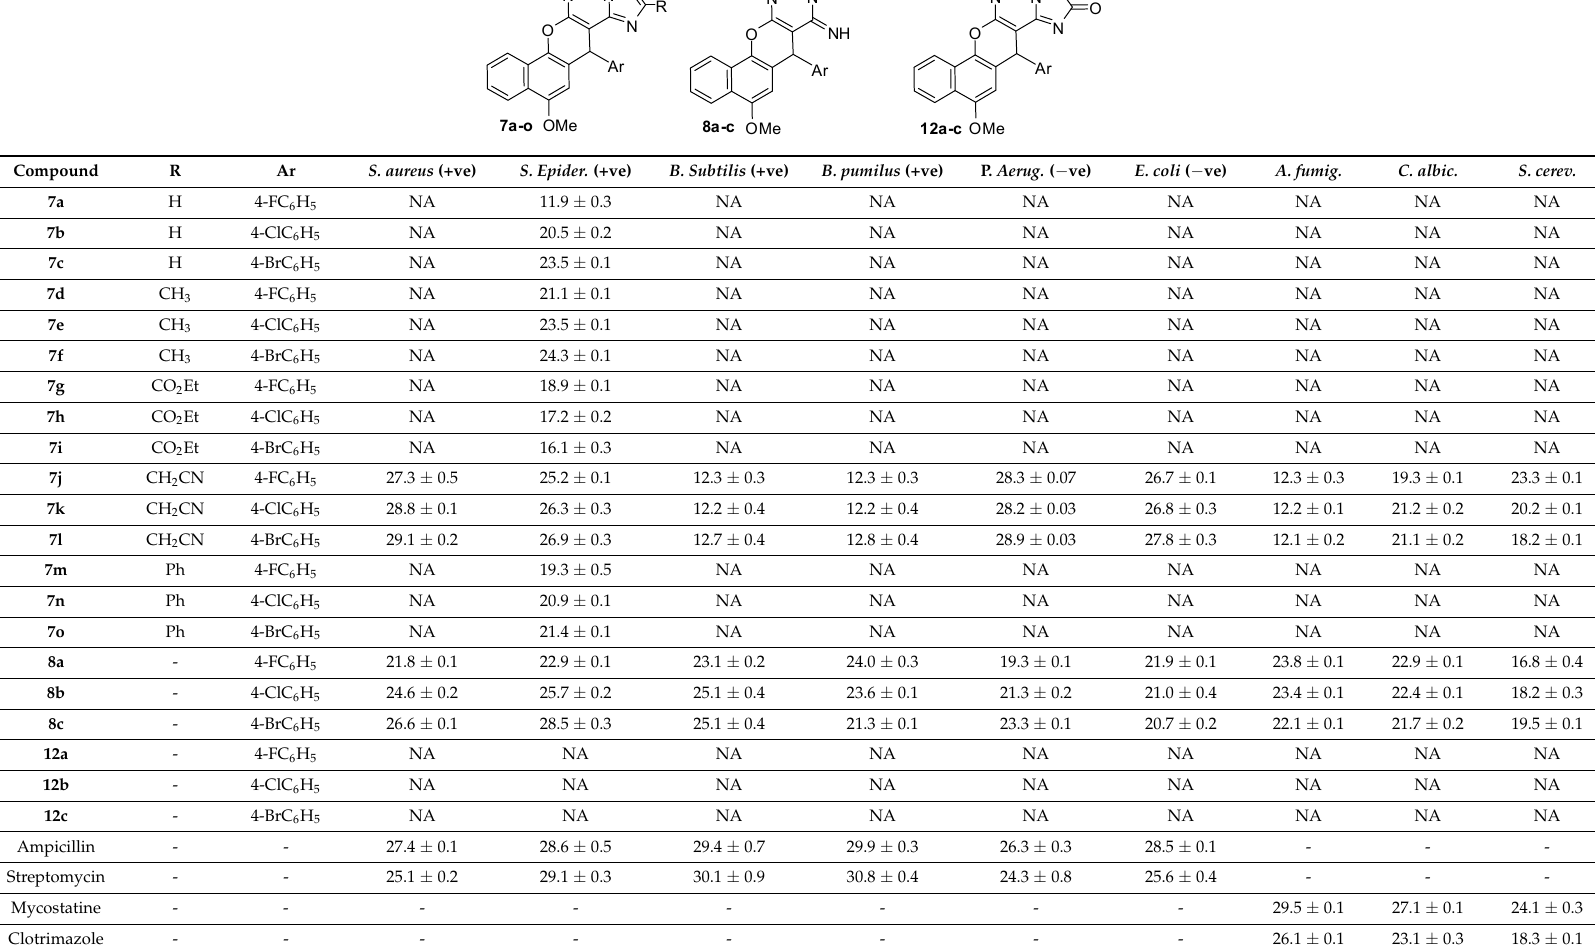
Table 1. Antimicrobial screening for compounds 7a – o , 8a – c and 12a – c (25 µ g/mL).